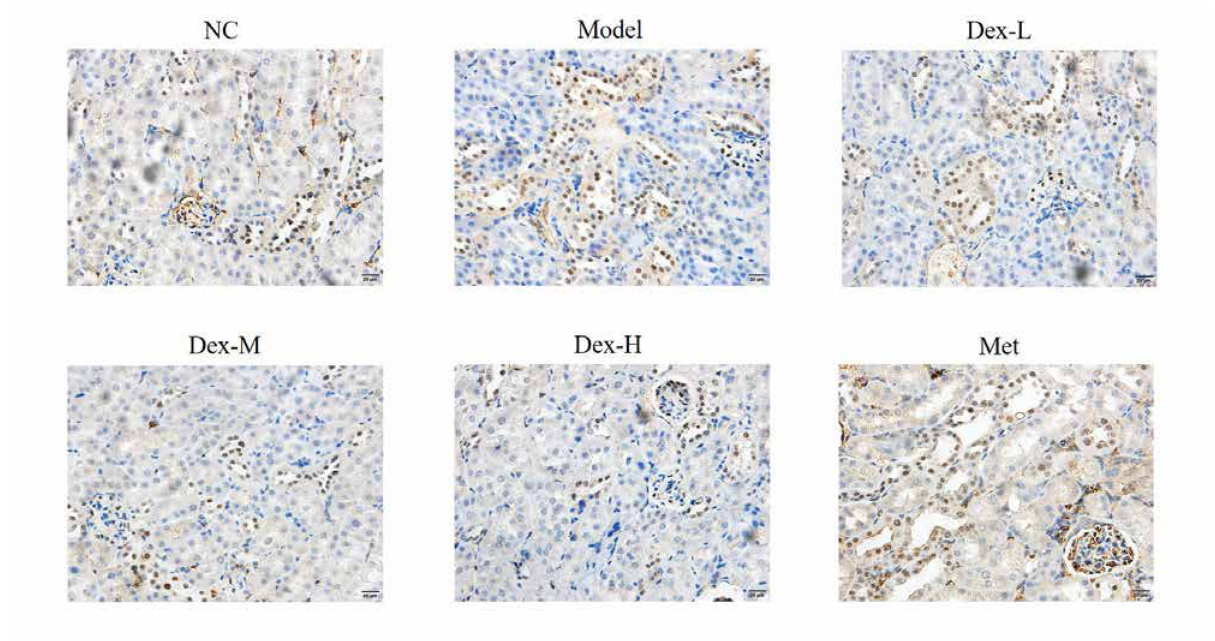
Figure 4: The RhoA protein expression of different groups by IHC assay (400×) NC: normal control group; Model: DN model group; Dex-L: Dex low-dose treated group; Dex-M: Dex medium-dose treated group; Dex-H: Dex high-dose treated group; Met: Metformin treated group